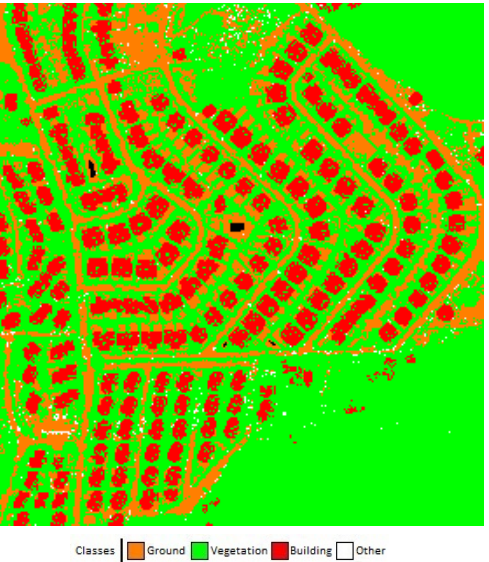
Figure 7. The classified points cloud of the test area with Approach 2 (with spatial-based